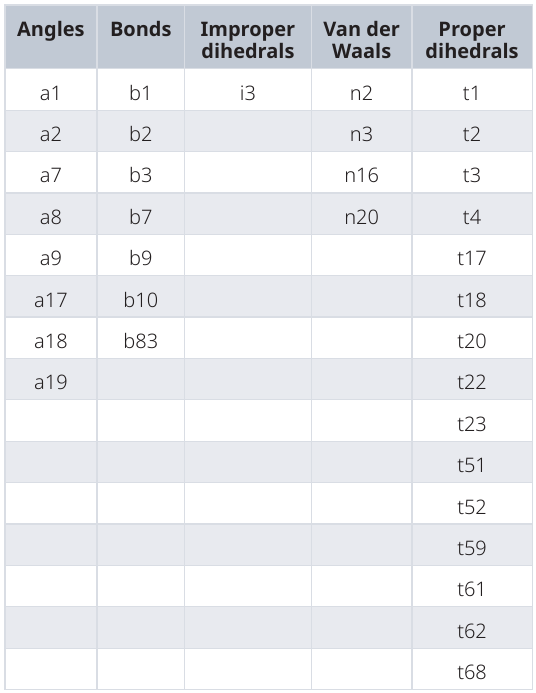
Table 2. OpenFF-1.2 force field parameters identified to be overrepresented in high TFD molecules. These parameters show statistically significant differences (p < 0.05) in representation ratios of the high TFD molecules compared to ratios of the full molecule set. Refinement of these parameters may